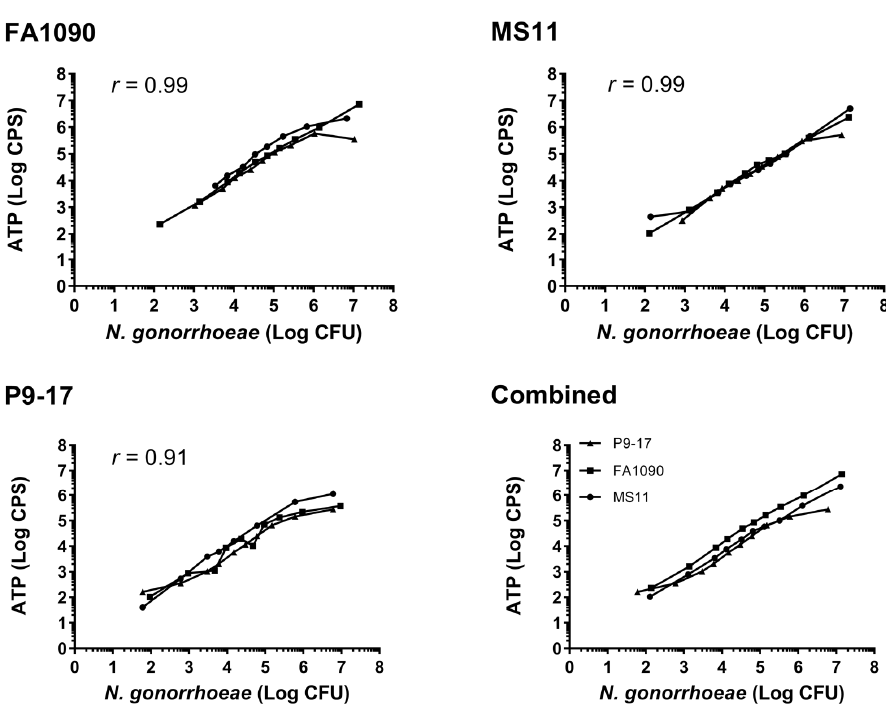
Figure 1. Quantification of Neisseria gonorrhoeae by detection of colony forming units (CFU) versus ATP. Results show mean values from three independent assays, presented either individually for each strain or as combined mean values from all three strains. The correlation between CFU and ATP was calculated for each strain using a two-tailed Pearson coefficient ( p < 0.001 for each strain).